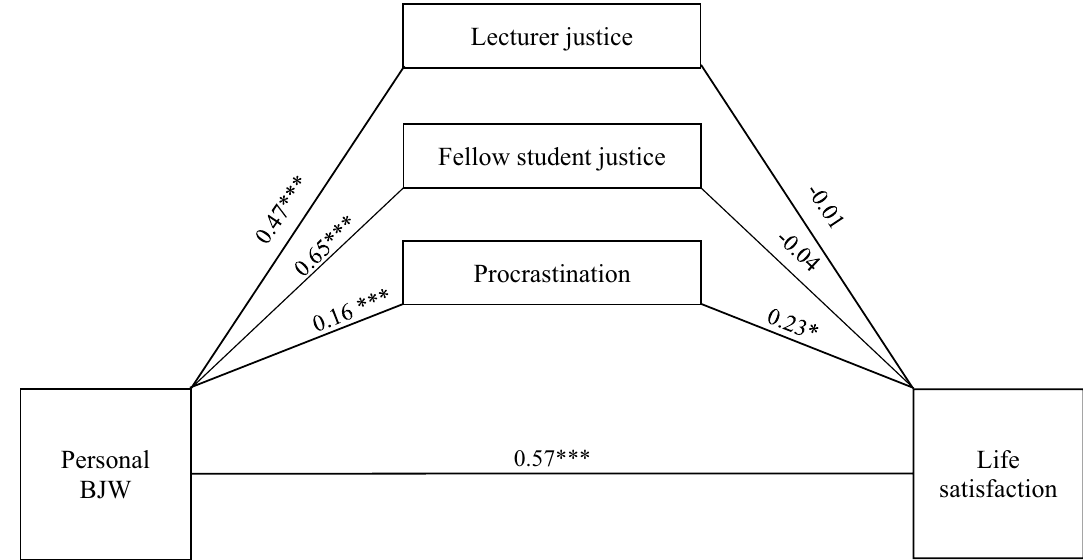
Figure 1. Mediation analysis of the relation between personal BJW and life satisfaction considering the control variables. Total indirect effect of procrastination ( b = 0.04), lecturer justice ( b = − 0.01) and fellow student justice ( b = − 0.02) was: b = 0.00, 95% CI [− 0.09; 0.09]. Estimates are based on a bootstrapping procedure with 5000 bootstrap samples. *p < 0.05, ***p < 0.001. Used Process 77 Model 4. Direct effects on the paths. Values describe unstandardized path